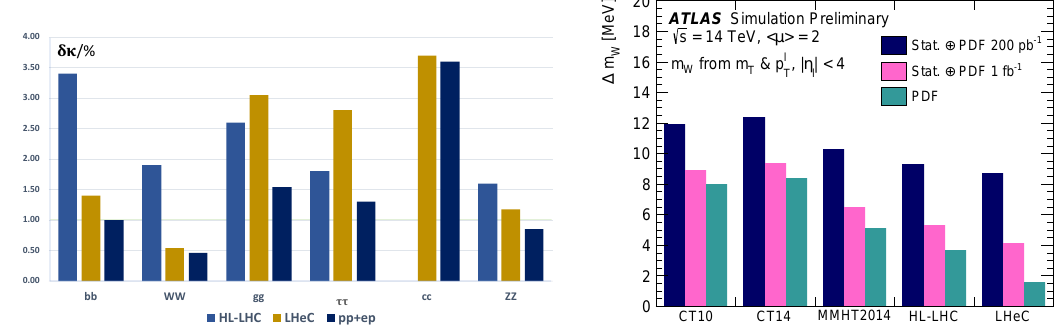
Figure 5: Through direct DIS production, the LHeC will have substantial constrain- ing power over a variety of high-energy observables which will impact the HL-LHC program. Inclusion of LHeC pseudodata reduces the uncertainty in determinations of the BSM couplings of the Higgs boson (left) to the percent-level or less, partic- ularly for the bb , WW , and ZZ channels. Similarly, PDF improvements driven by the LHeC can dramatically reduce the W -mass uncertainty, ∆ m than a factor of 2 relative to an HL-LHC-only scenario. Both panels are taken from the recent LHeC whitepaper, Ref. [ 5 ]